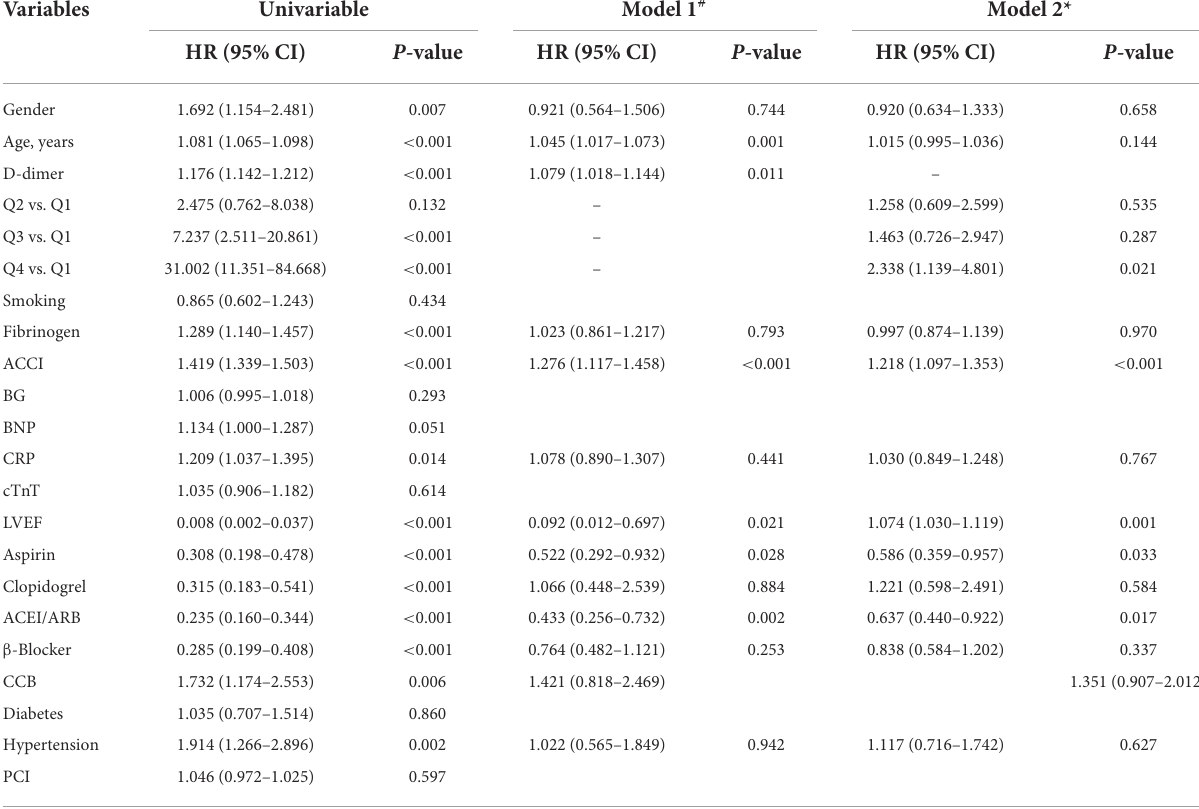
TABLE 5 The univariate and multivariate Cox regression analyses of all-cause death in patients with NSTEMI. Variables